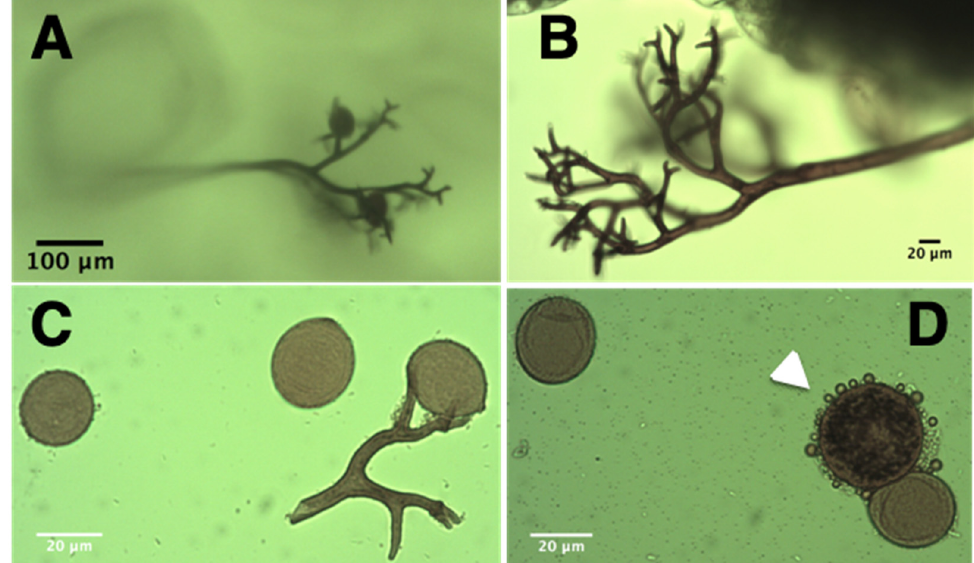
Figure 1. Stained sporangiophores, sporangiospores and oospores of P. variabilis. ( A ) sporangio- phore branches loaded with sporangiospores growing on the adaxial (top) surface of quinoa leaves; ( B ) sporangiophores growing from quinoa leaves; ( C ) stained sporangiospores of P. variabilis , note the broken branch holding sporangia; ( D ) an oospore (white arrow) next to a